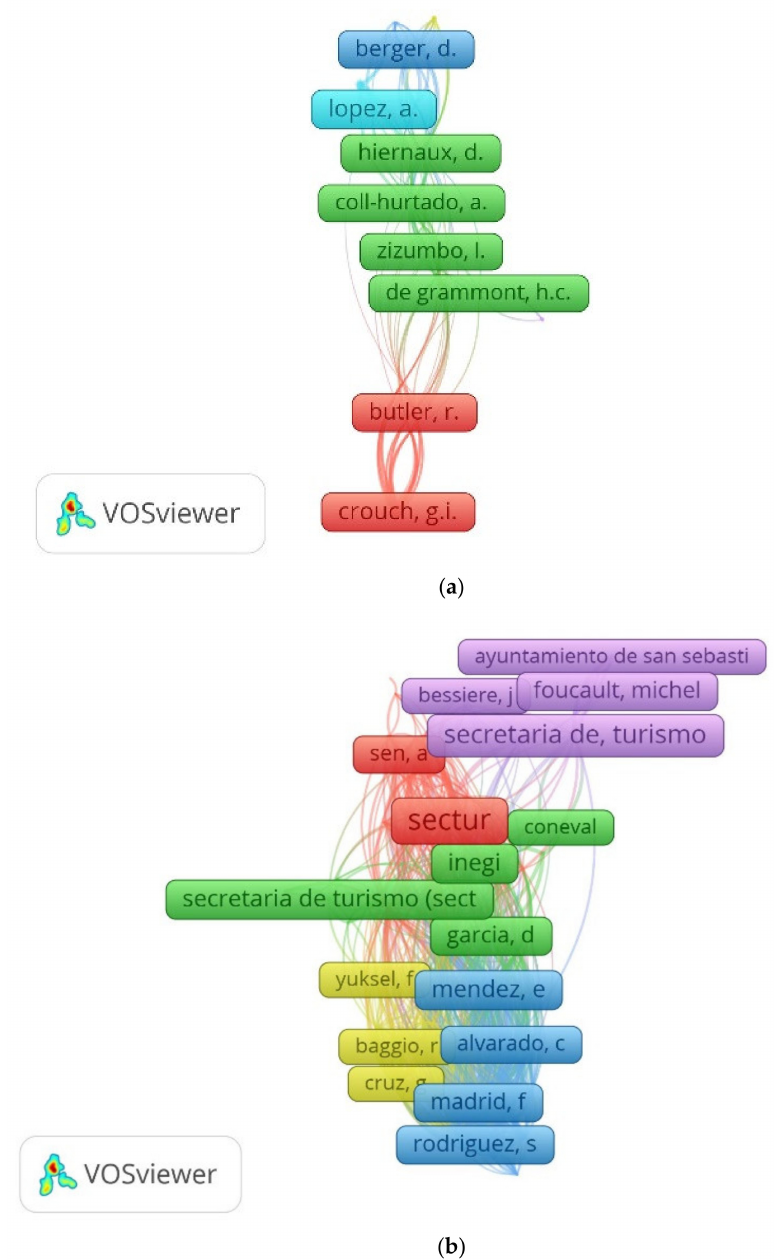
Figure 9. Network of co-citations for authors, ( a ) Scopus, ( b ) WoS. Source: Own